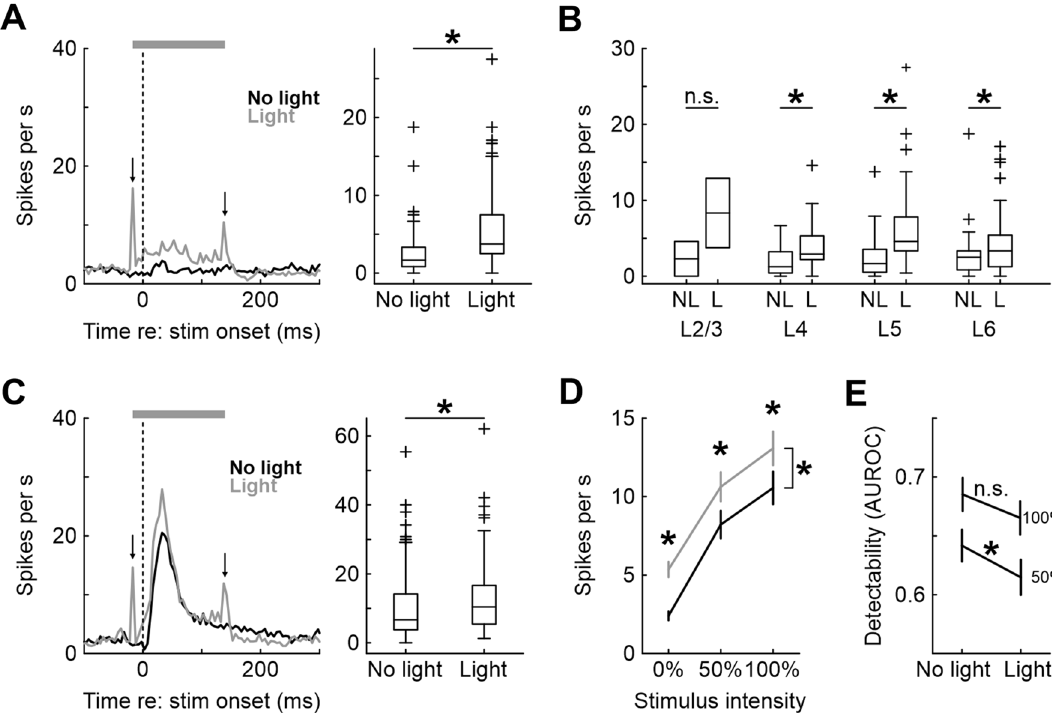
Figure 4. Effect of optogenetic inhibition of PV+ interneurons on spontaneous and single-whisker stimulus evoked activity in single neurons. ( A ) Left: Mean PSTH across n = 98 single units with and without light application (gray and black lines, respectively). In this and the following panels, downward pointing arrows indicate light onset and offset artifacts, gray horizontal bar denotes the period of light application, and dashed vertical line depicts stimulus onset. Bin size is 5 ms. Right: Boxplots for mean spontaneous firing rates of n = 98 single units across all cortical layers comparing activity with and without light application. ( B ) Spontaneous activity with (L) and without light application (NL) for all single units shown separately for cortical layers. ( C ) Left: Mean PSTH across all single units in response to a maximum-amplitude W1 deflection, with and without light application. Right: Boxplot comparing mean neuronal response to the stimulus. ( D ) Left: Mean neuronal response to three different stimulus intensities, with and without light. Error bars represent SEM. ( E ) Detectability (AUROC) across all single neurons for 50% and 100% stimulus amplitudes compared to the null stimulus, both with and without light